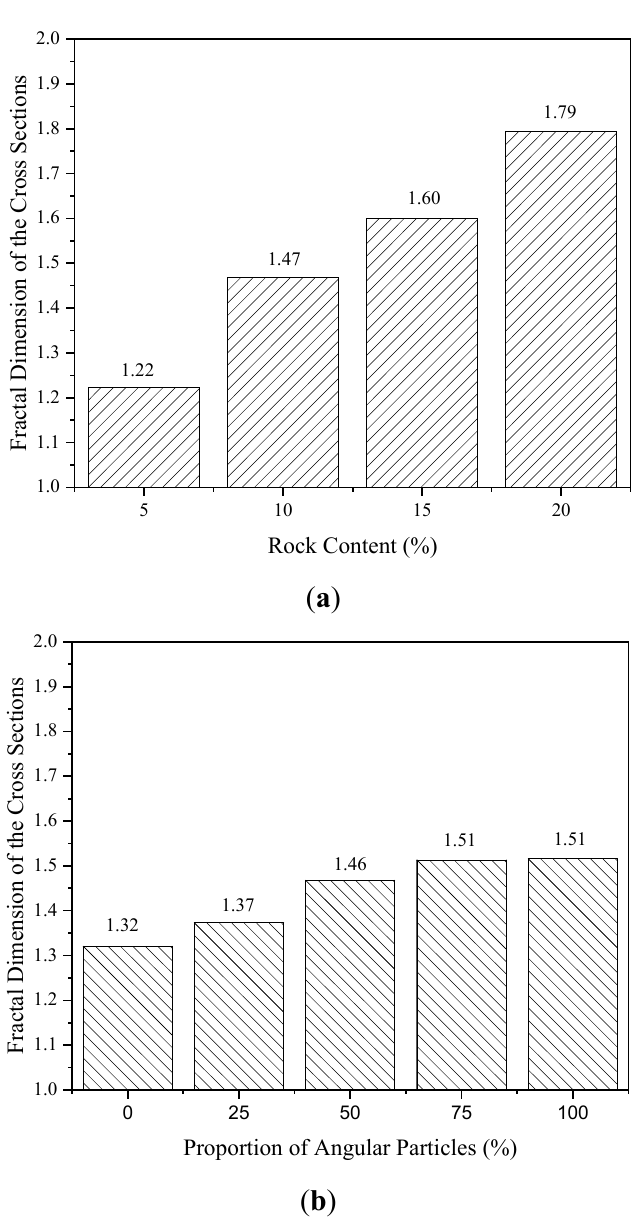
Figure 9. Relationship between the rock content ( a ) and angular particle proportion ( b ) with the